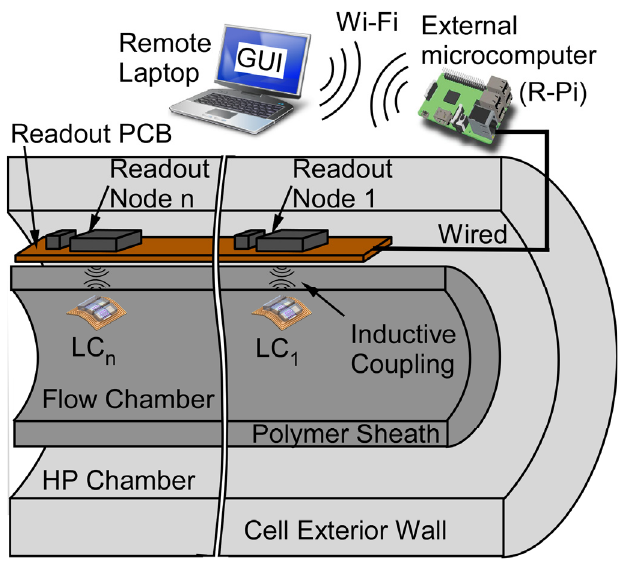
Figure 1. Cross-sectional view of a passive wireless pressure gradient measurement (PGM)